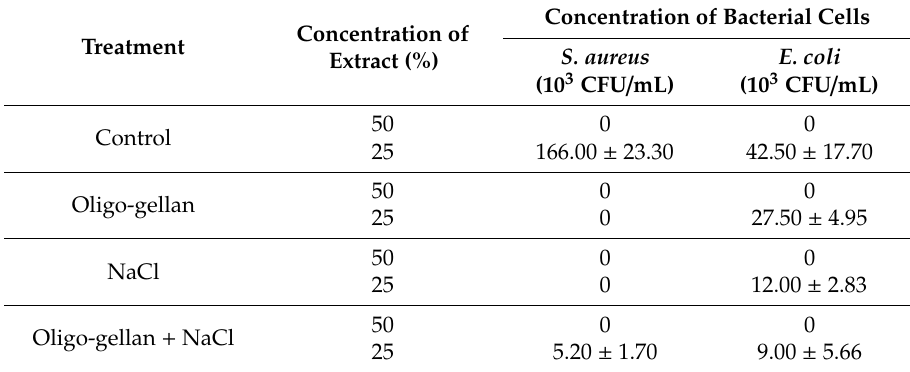
Figure 3. E ff ects of oligo-gellan pretreatment (100 ppm) and salt stress (100 mM NaCl) on antioxidant activity of red perilla plants assessed by 2,2-diphenyl-1-picrylhydrazyl (DPPH) ( a ) and 2,2 (cid:48) -azino-bis(3- ethylbenzothiazoline-6-sulfonic acid (ABTS) ( b ). Bars represent means of three biological replicates ± standard deviations. Di ff erent letters indicate statistical di ff erences at p ≤ 0.05 (Tukey’s test). Table 3. E ff ects of oligo-gellan pretreatment (100 ppm) and salt stress (100 mM NaCl) on the activity of red perilla extracts against Staphylococcus aureus and Escherichia coli . The number of bacterial cells are presented as an average of three samples with standard